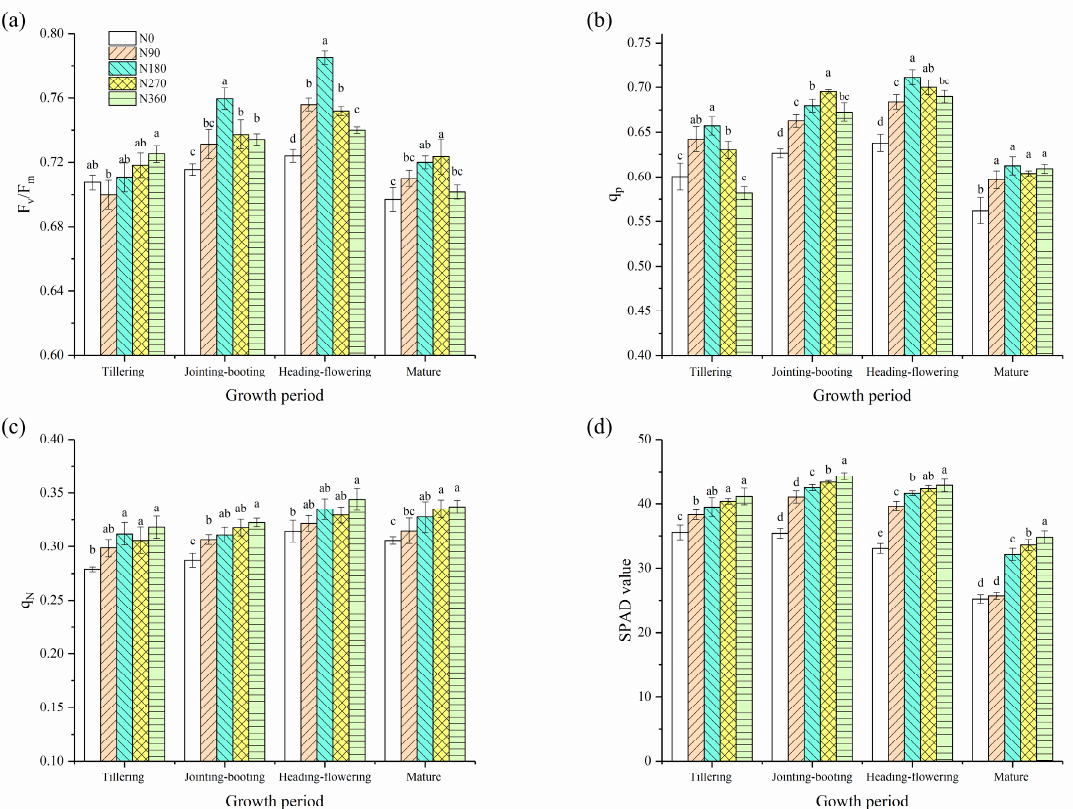
Figure 2. Effects of N application rates on fluorescence parameters and SPAD value of rice leaves. ( a ) F v /F m value; ( b ) q P value; ( c ) q N value; ( d ) SPAD value. Vertical bars indicated the standard error. Different letters with the same growth period indicated significant differences at p < 0.05 according to the Duncan’s test. Tillering means tillering stage; jointing–booting means jointing–booting stage; heading–flowering means heading–flowering stage; mature means mature stage.